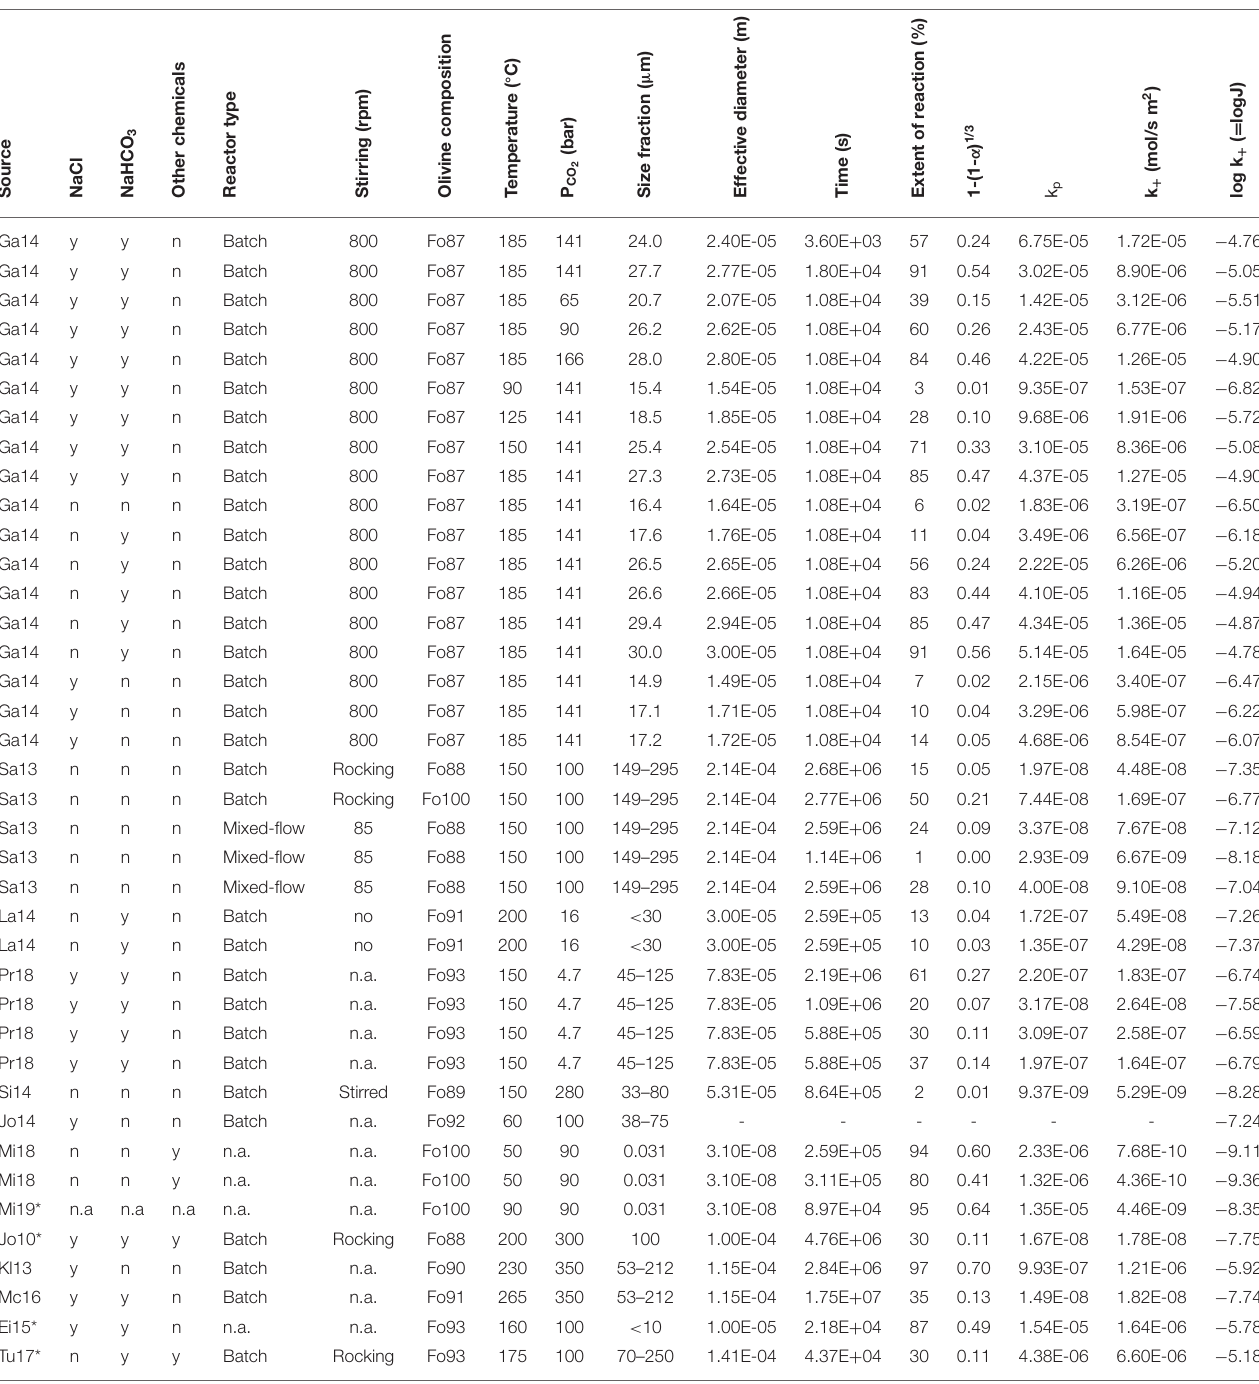
TABLE 4 | Summary of literature data presented on Figure 8